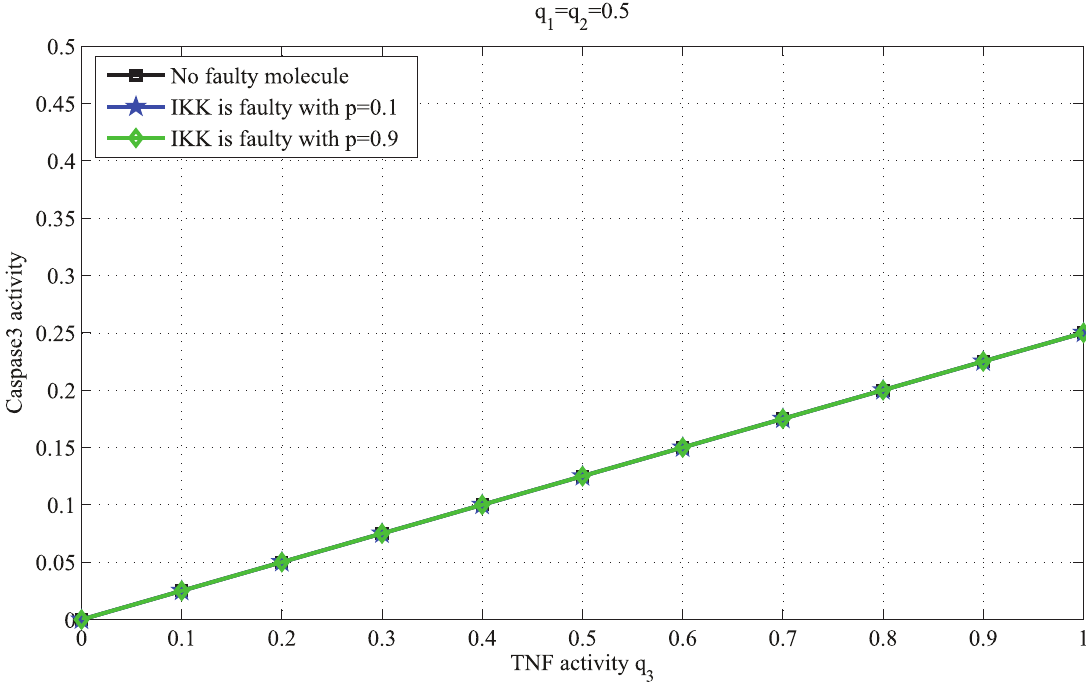
Figure 6. Caspase3 activity in terms of the TNF activity q 3 , when IKK is faulty. In this figure the activity of TNF changes from 0 to 1, whereas the activities of EGF and insulin are the same, q 1 ~ q 2 ~ 0 : 5 . We observe that the output activity does not change, whether IKK is faulty or not. This is because IKK’s vulnerability is zero (as shown in Methods).